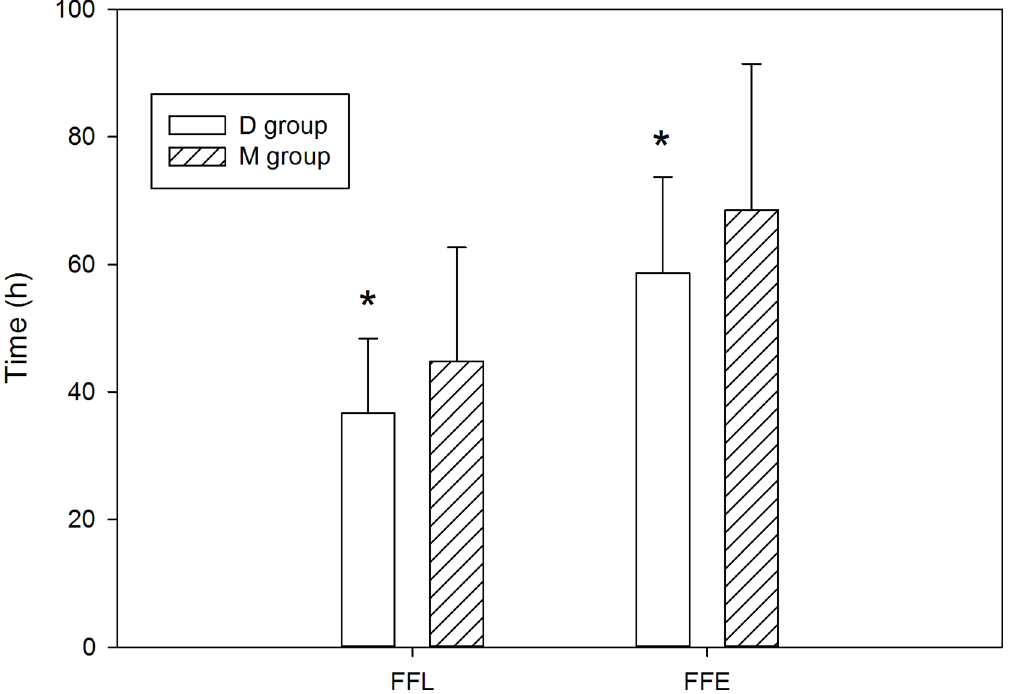
Fig 2. Time to postoperative first flatus and first feces of the two groups. Values are mean ± SD. FFL = first flatus, FFE = first feces, D = dexmedetomidine, M = morphine. * P < 0.05 compared with M